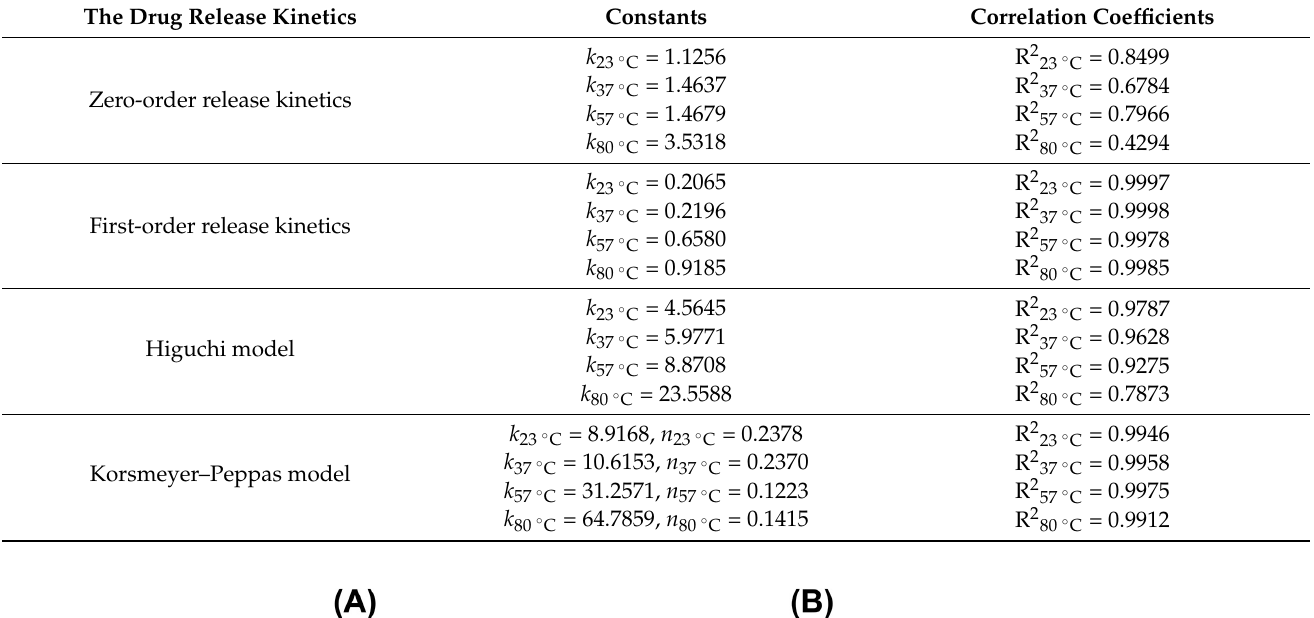
Table 2. The drug release kinetic parameters for synthesized Fe 3 O 4 @CS-ACVA-TB nanoparticles.